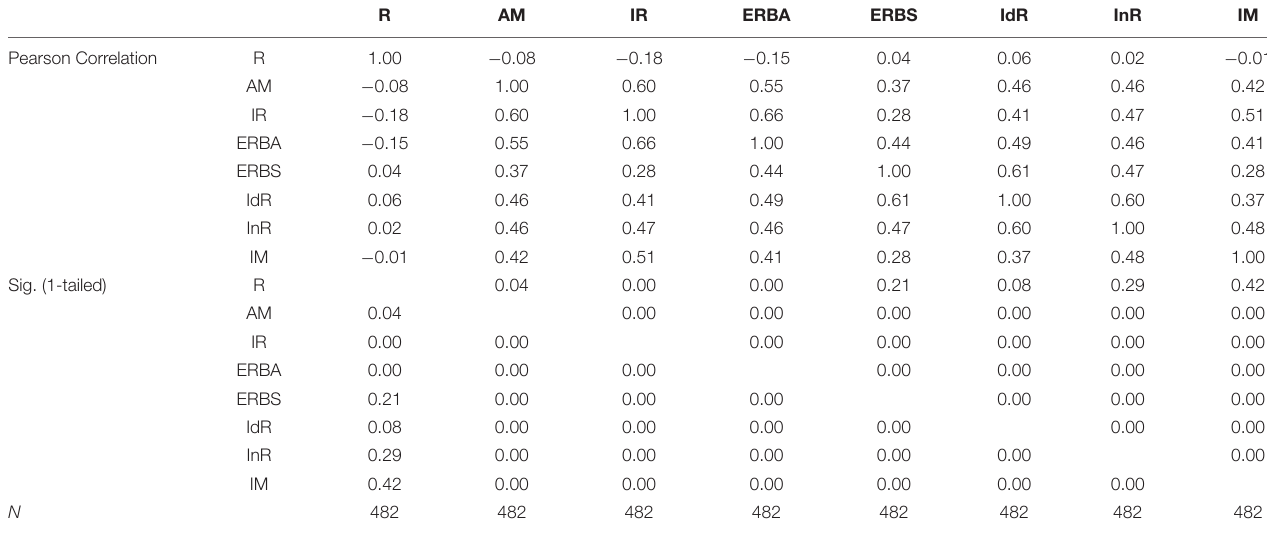
TABLE 4 | Correlations among the components of motivation and